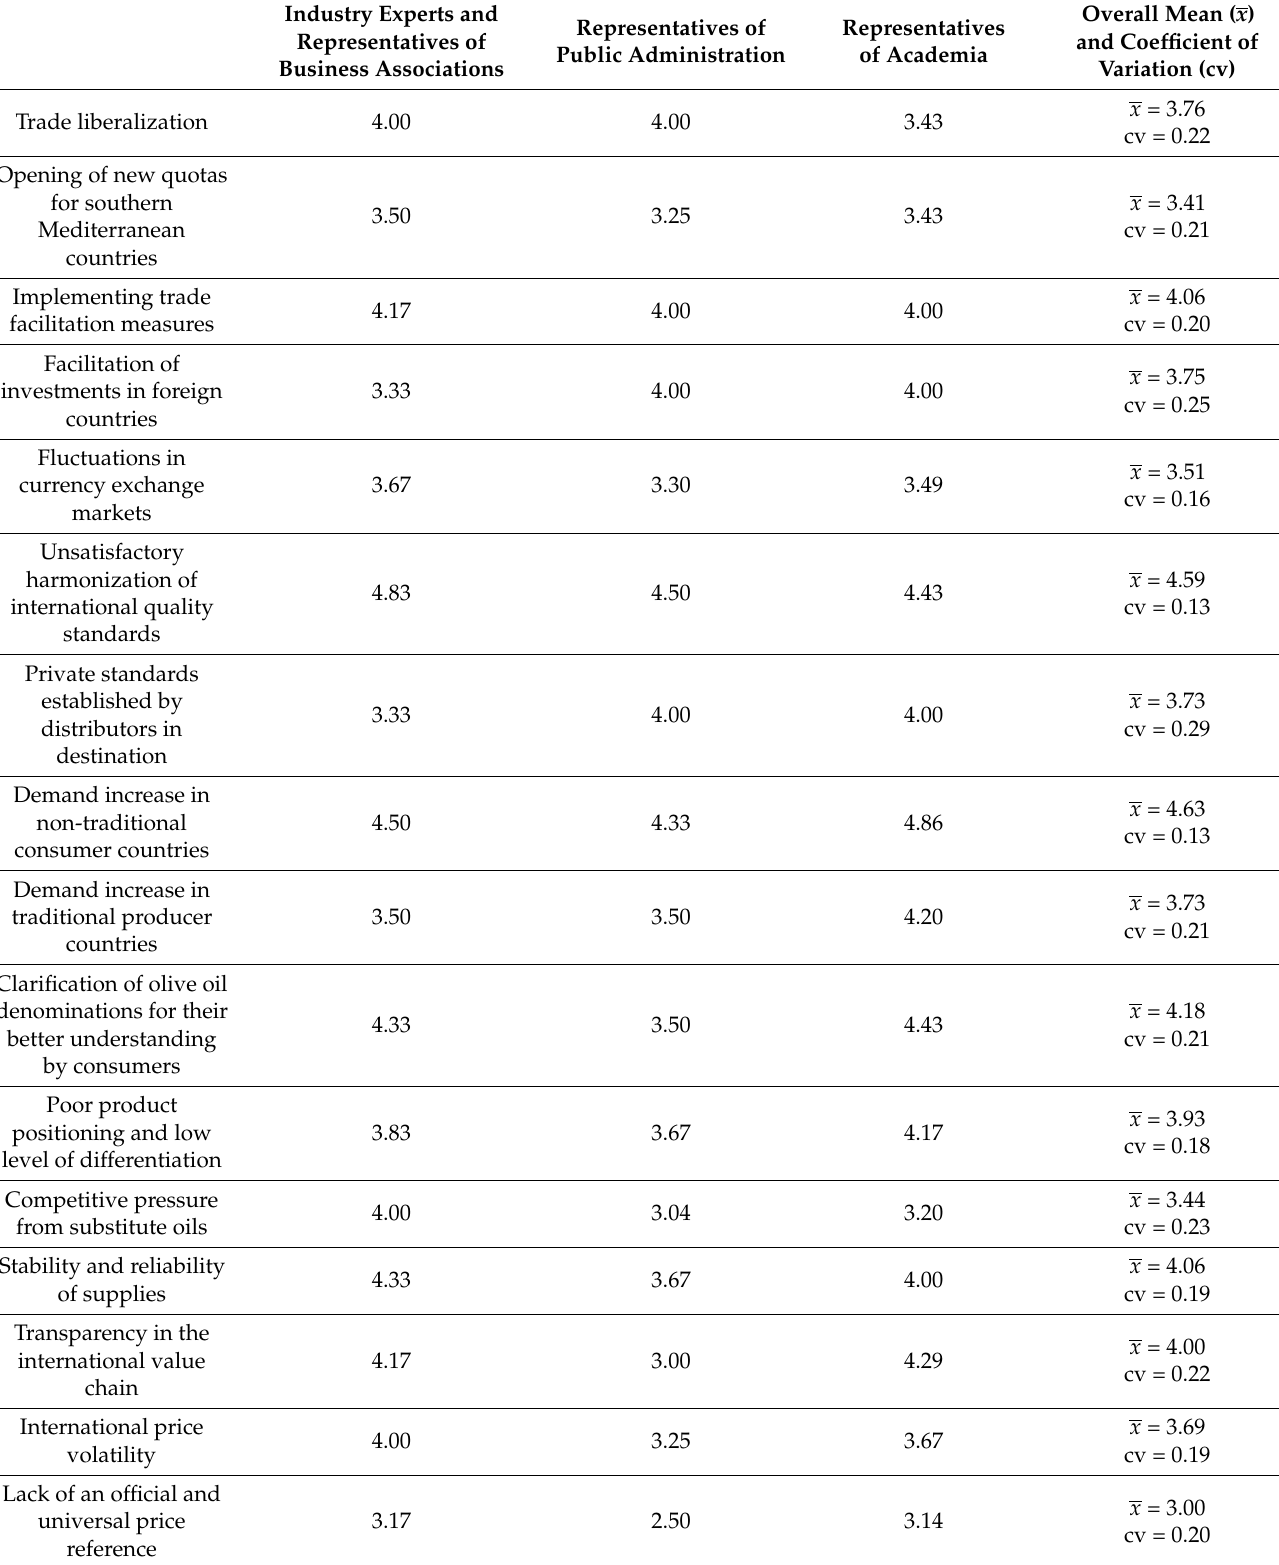
Table 5. Major challenges in the international trade of olive